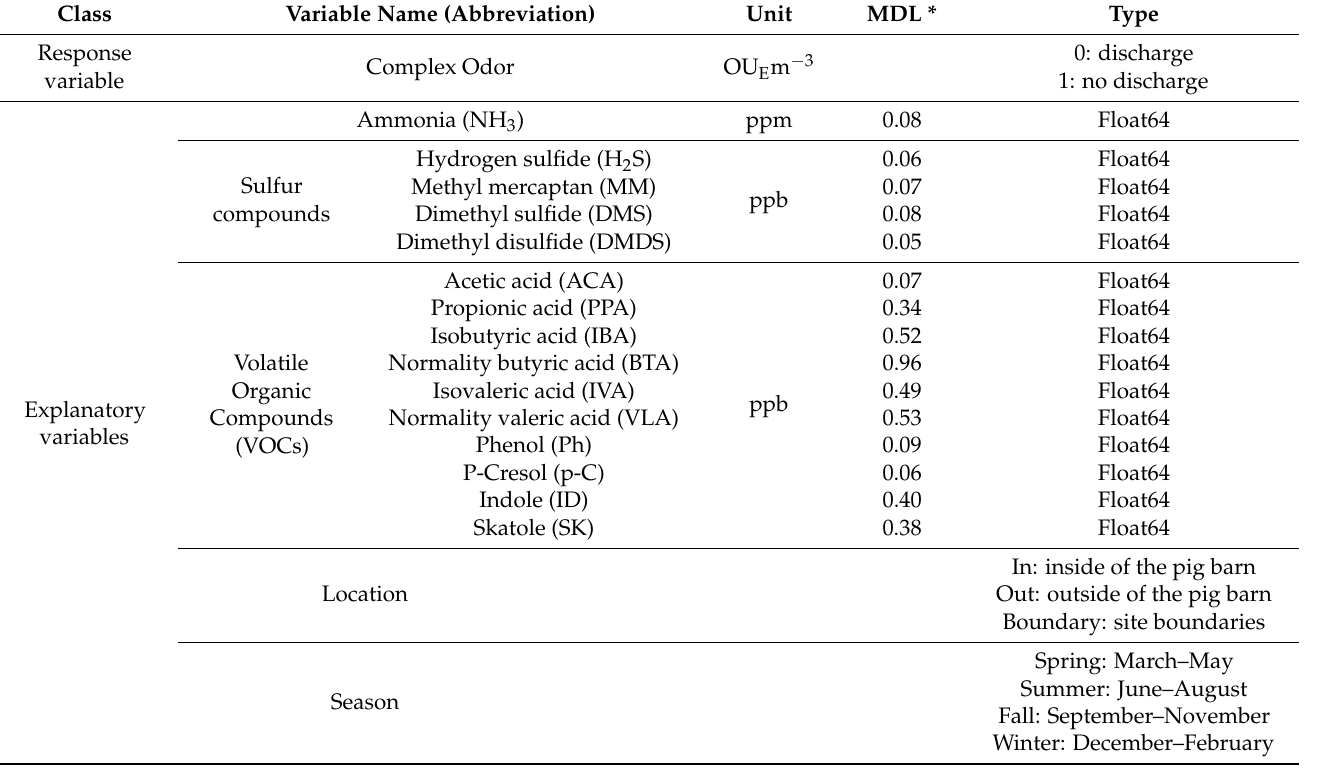
Table 2. Summary of study